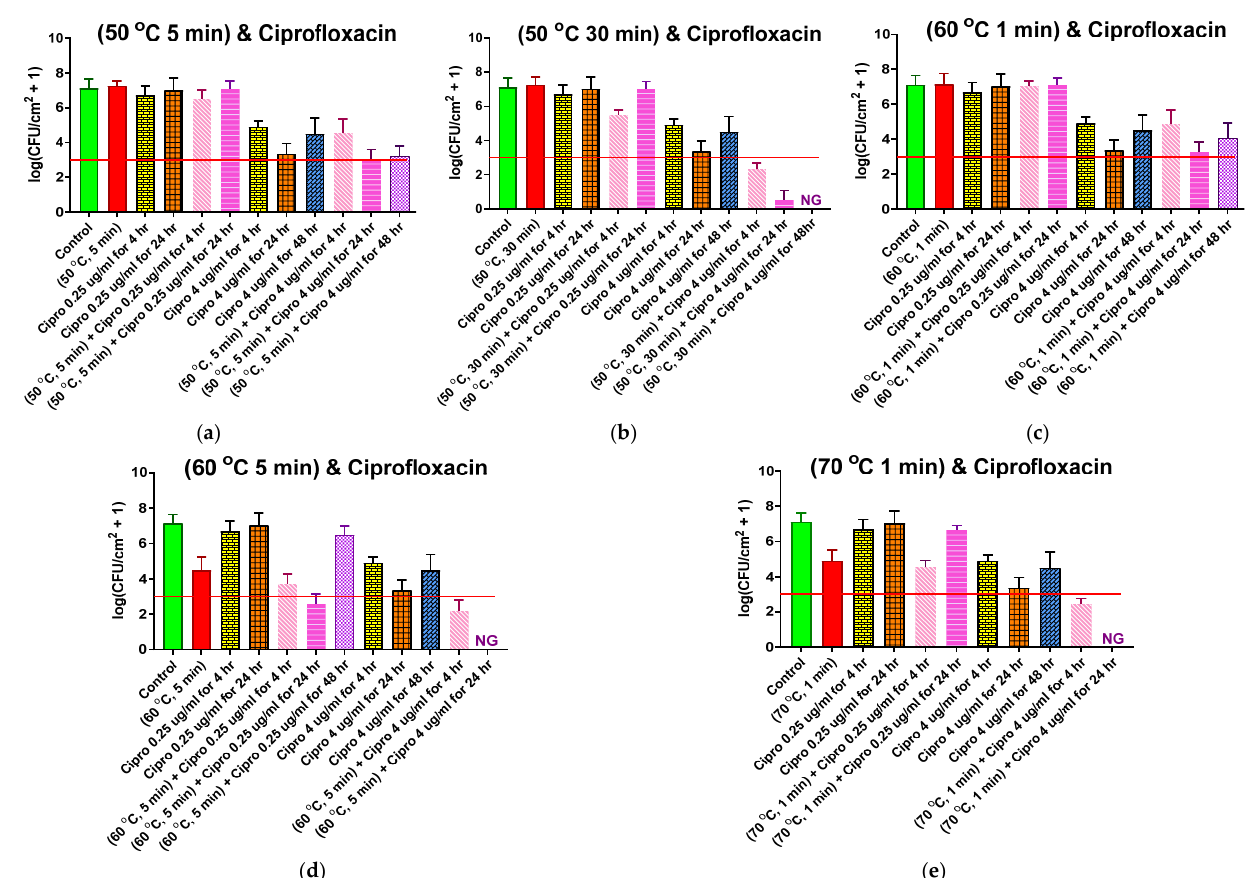
Figure 4. Combined ciprofloxacin and thermal shock effect on the P. aeruginosa shaker table biofilm population. Each panel shows results for the thermal shock and antibiotic exposure indicated. Red horizontal lines show the critical population density below which thermal shocked bacterial biofilms are not viable. Error bars indicate standard deviation for at least six slides from three different dishes.